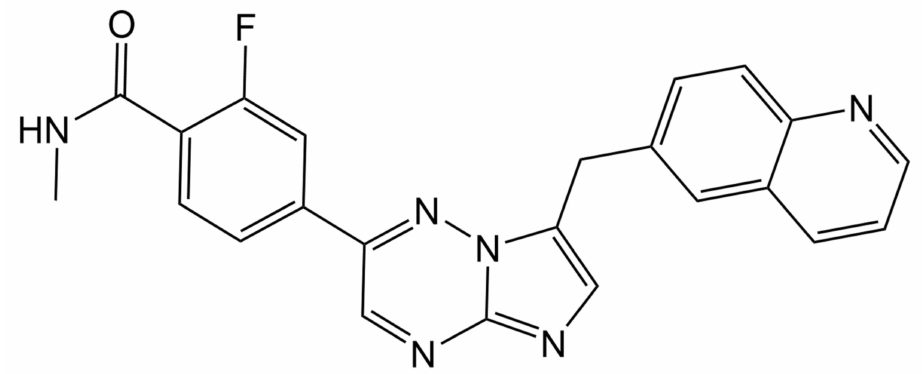
Figure 1. Capmatinib chemical